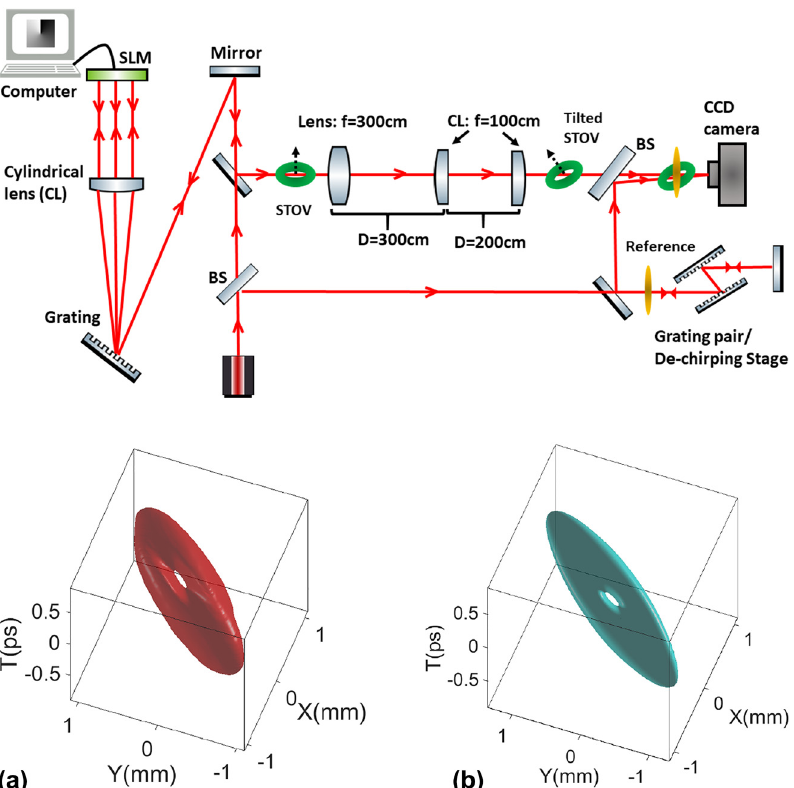
Figure 5: Experimental and simulated iso- intensity plot of the STOV with OAM tilt generated by cylindrical lens system with = 45 ◦ : (a) experimental rotational angle 𝜃 r result; (b) simulation